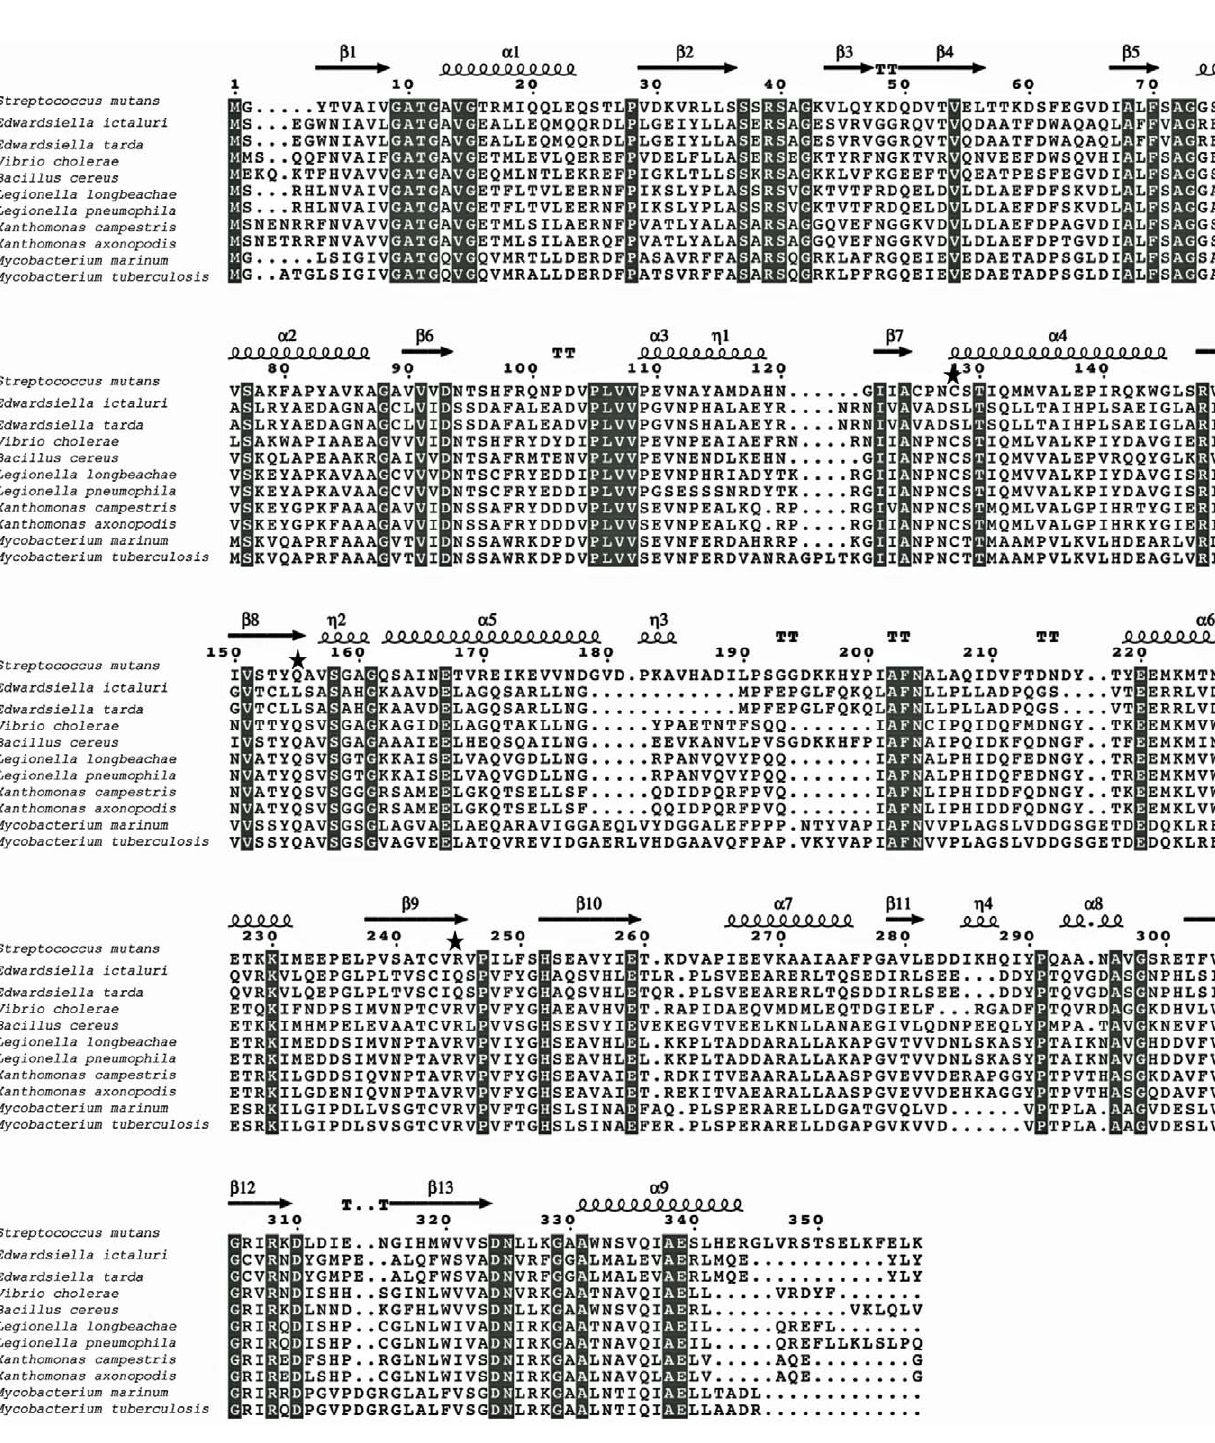
Figure 2. Sequence alignment among representative members of the AsdB family. The secondary structure at the top of the alignment corresponds to the S. mutans AsdB enzyme (spirals represent a -helix; arrows represent b -sheet). Conserved amino acids residues are indicated in grey. The stars indicated the key catalytic active site residues not present in AsdB from Edwardsiella. The AsdB sequences were obtained from NCBI’s Entrez Protein database for Streptococcus mutans NP_721384.1; Edwardsiella ictaluri YP_002934124; Edwardsiella tarda YP_003296462; Vibrio cholerae YP_001217630.1; Bacillus cereus YP_085142.1; Legionella longbeachae CBJ10915; Legionella pneumophila YP_096311.1; Xanthomonas axonopodis NP_643032.1; Xanthomonas campestris NP_637897.1; Mycobacterium tuberculosis NP_218225.1; Mycobacterium marinum